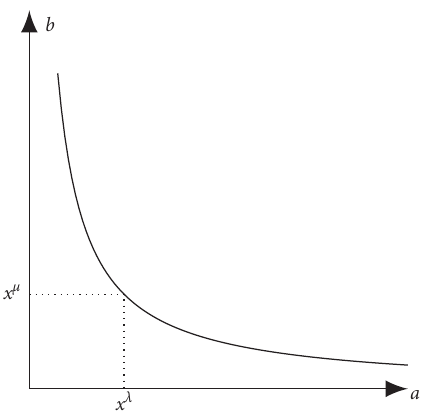
Figure 1: Dirichlet’s hyperbola method.